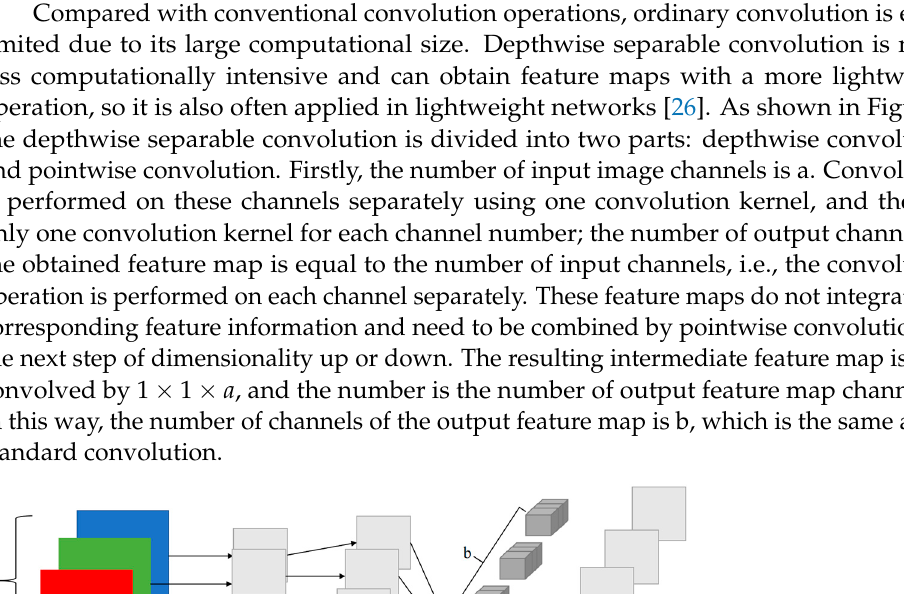
Figure 2. Structure of the Ghost Module.